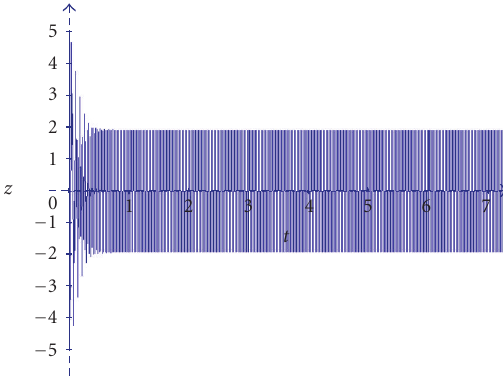
Figure 6.3 . Bounded solution of (5.2) in the point B (529 . 45,100), a 0 = 5.